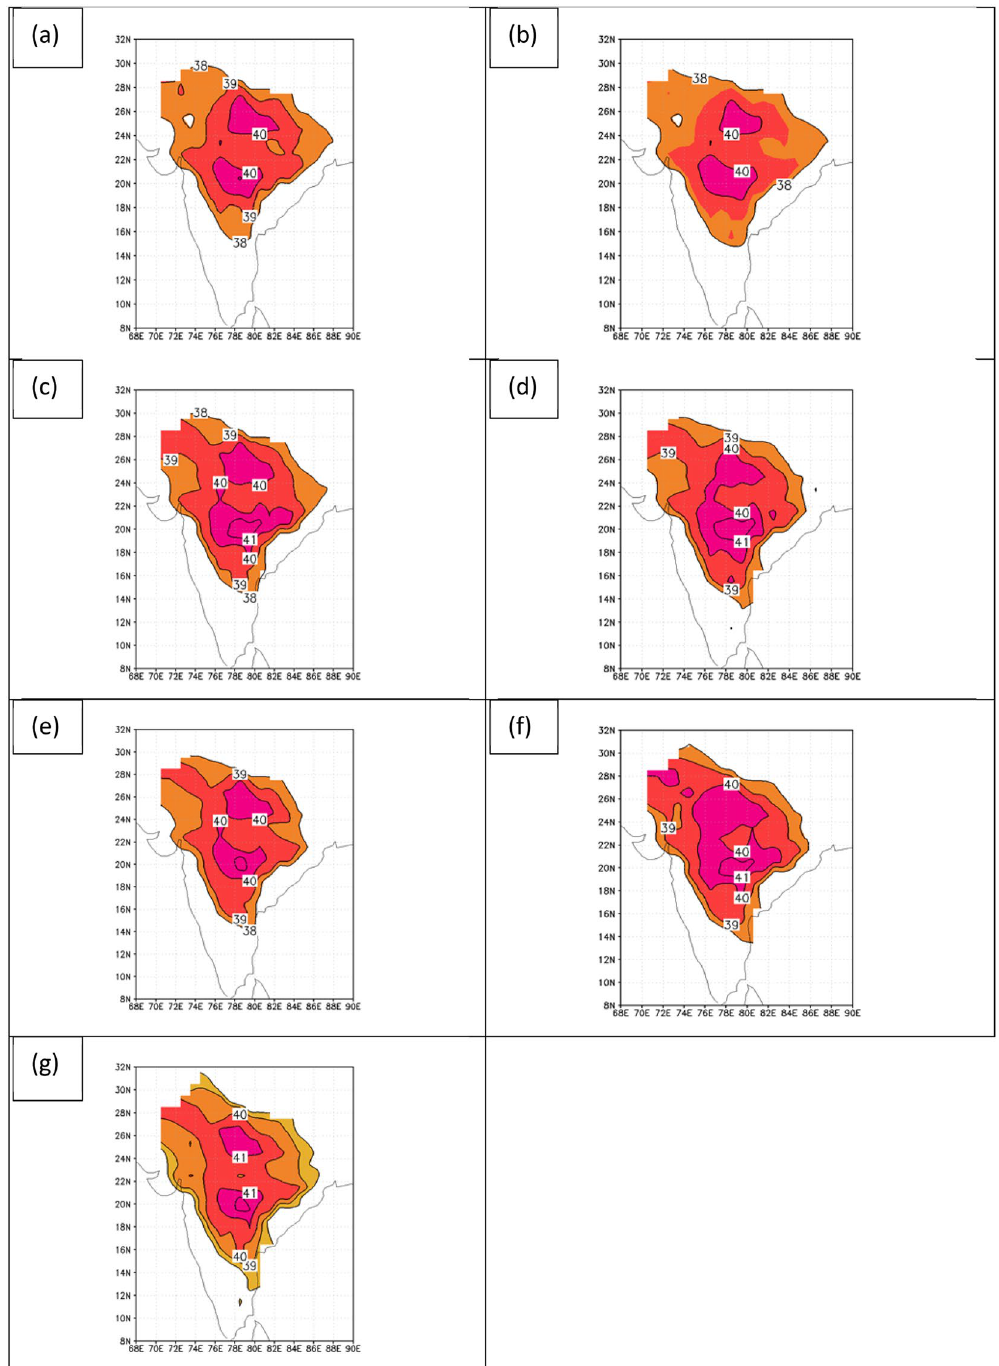
Figure 1. Decadal mean daily maximum temperature for the period April 1 to May 31. The decades shown are for ( a ) 1950s, ( b ) 1960s, ( c ) 1970s, ( d ) 1980s, ( e ) 1990s, ( f ) 2000s, and ( g ) 2010s. Figures are generated using GrADS 2.2.0